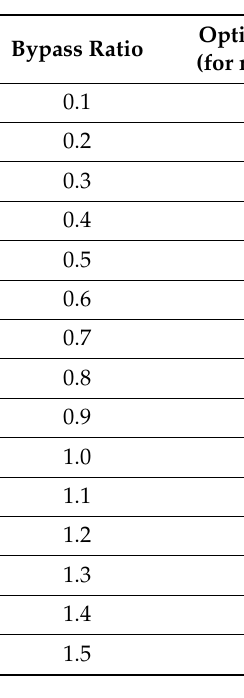
Table 5. Optimal FPR